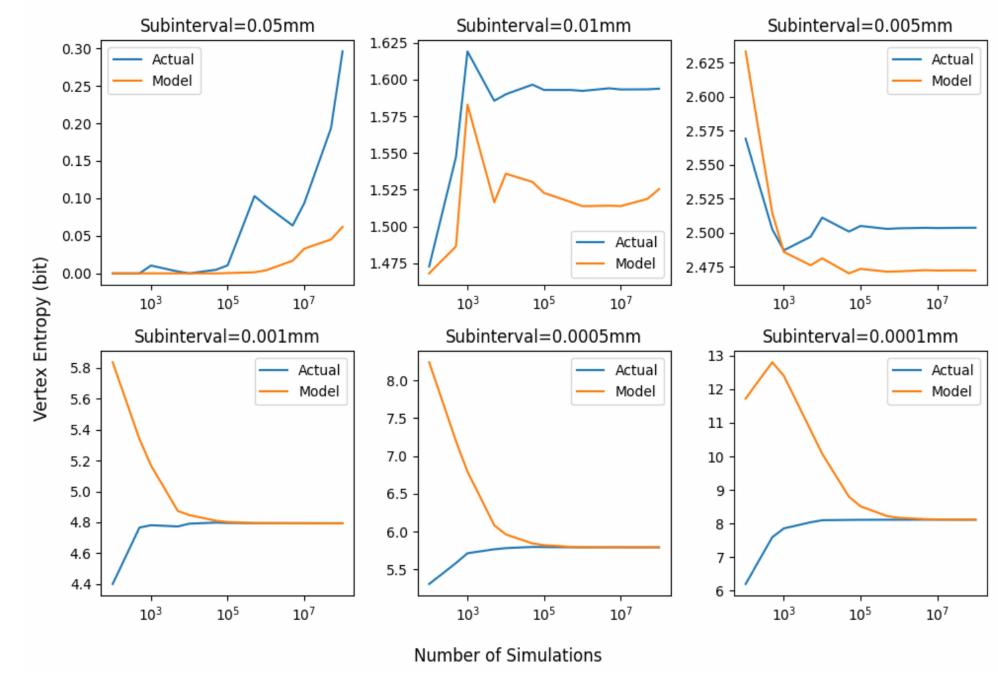
Figure 7. The simulation results of Example